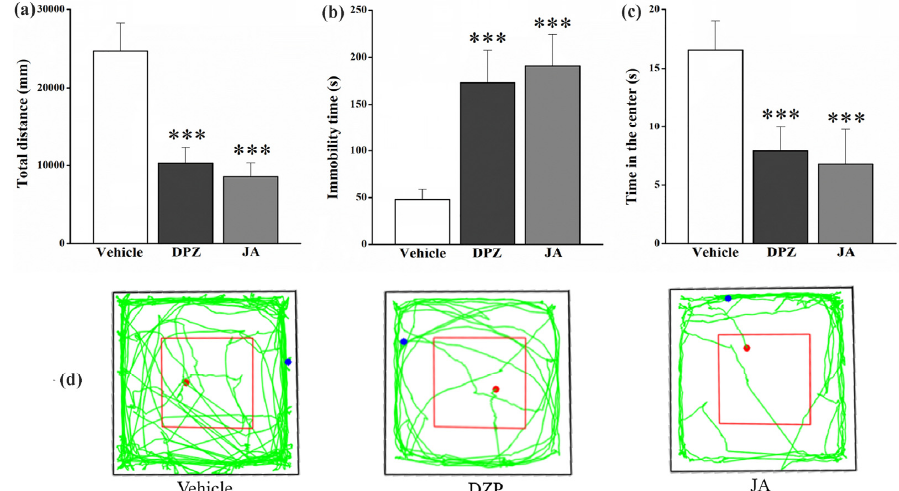
Figure 8. Effects of jegosaponin A (JA) at 3 mg/kg on the total distance ( a ), the immobility time ( b ) and the time in the center ( c ) in the open field test. Motion tracks of mice in vehicle, DZP and JA groups ( d ); red frame: center zone, red point: start, blue point: finish. Vehicle: blank control, DZP: diazepam. Data are displayed as mean ± SD. *** p < 0.001 vs. vehicle group.